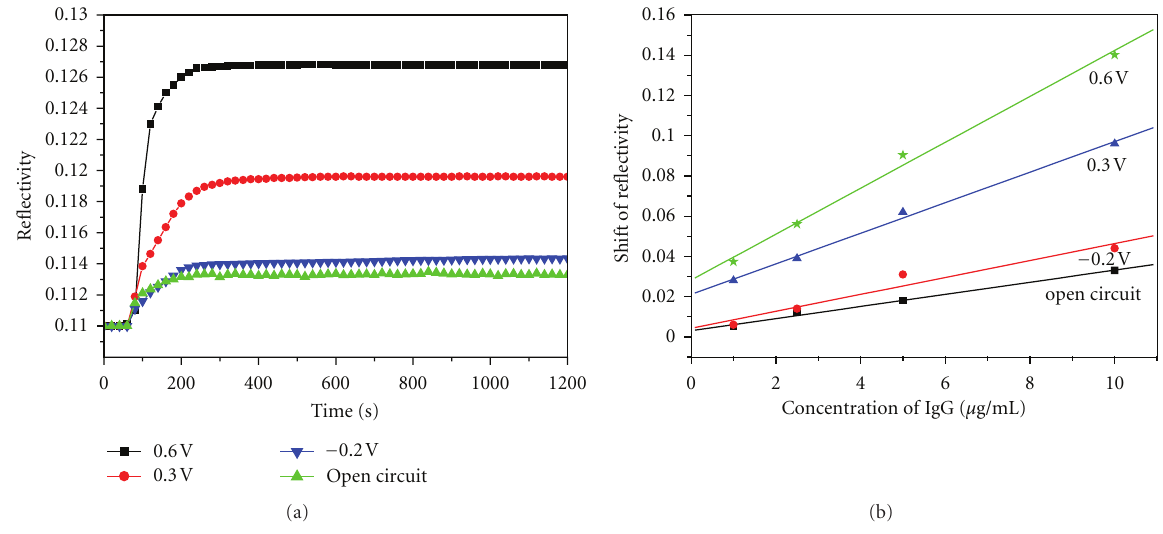
Figure 4: (a) SPR responses at di ff erent applied potentials for detection of human IgG (10 μ g/mL) at several constant potentials, and (b) the plot of the shift of reflectivity during binding process with concentration of IgG at di ff erent constant applied potentials [39].